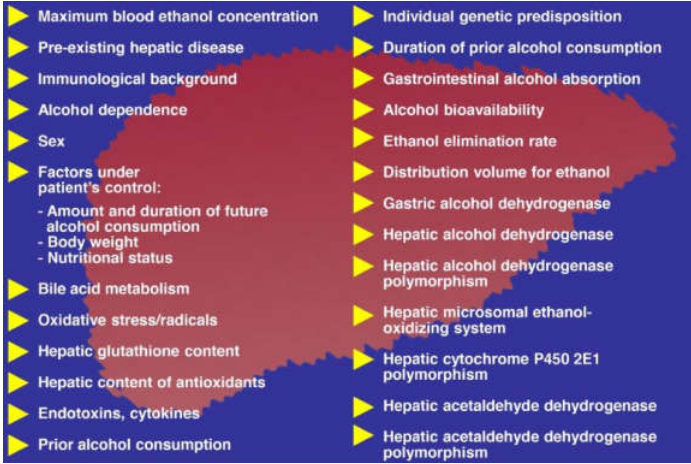
Figure 21. Hypothesis of risk factors of alcoholic cirrhosis.